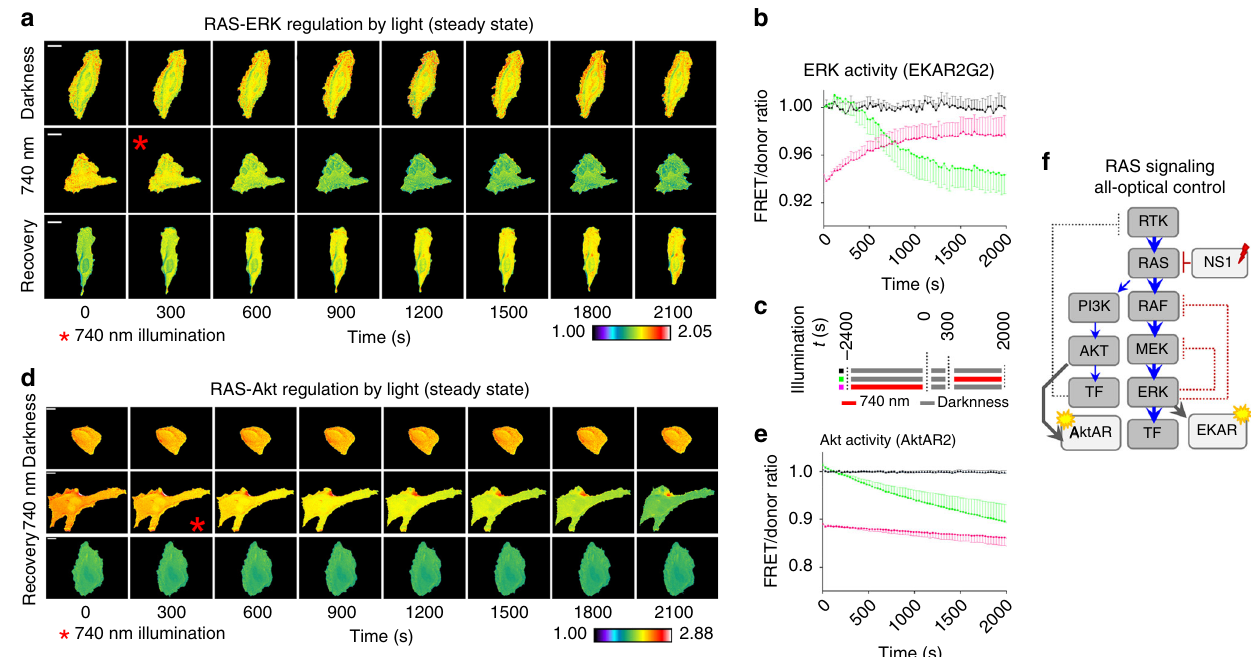
Fig. 9 All-optical control of endogenous RAS in steady state. a RAS regulation by light in cells expressing EKAR2G2, in serum. Epi fl